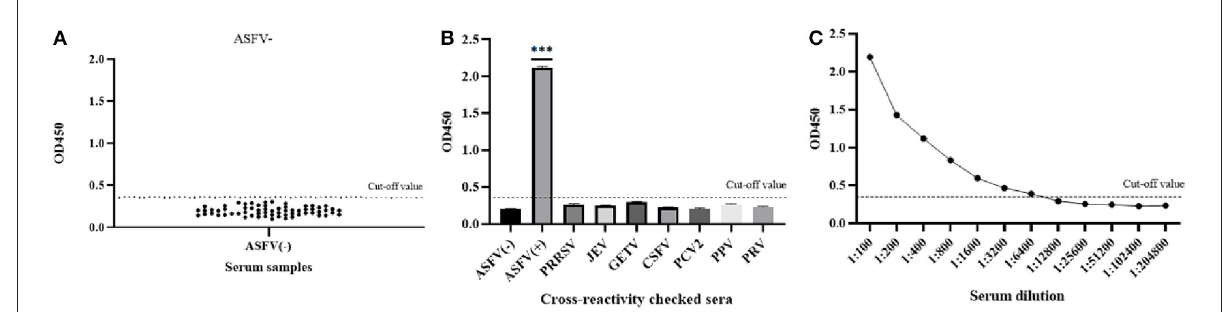
FIGURE3 Sensitivity and specificity of the pB602L-ELISA method. (A) Determination of the cut-off value of pB602L-ELISA (OD450 = 0.340). Distributions of OD values determined for ASFV-negative ( n = 64) serum samples using pB602L-ELISA. The average value (AV) of the negative sera was calculated, and the cutoff value was set at 0.340 (AV + 3 × SD). (B) The specificity test of the pB602L-ELISA method. ASFV-positive serum, ASFV-negative serum and PRRSV, JEV, GETV, CSFV, PCV2, PPV, PRV antibody-positive swine serum were measured using the pB602L-ELISA, and the OD450 values with all antisera except the ASFV-positive serum were lower than the cutoff value (0.340). (C) Sensitivity of the pB602L-ELISA method. Two-fold serial dilutions from 1:100 to 1:204,800 of ASFV-positive serum were tested by pB620L-ELISA method, and the highest dilution that could be detected using the cutoff value (0.340) was found to be 1:6,400, *** p < 0.001. Each dot represents a serum sample, and the dashed line indicates the cutoff value of the